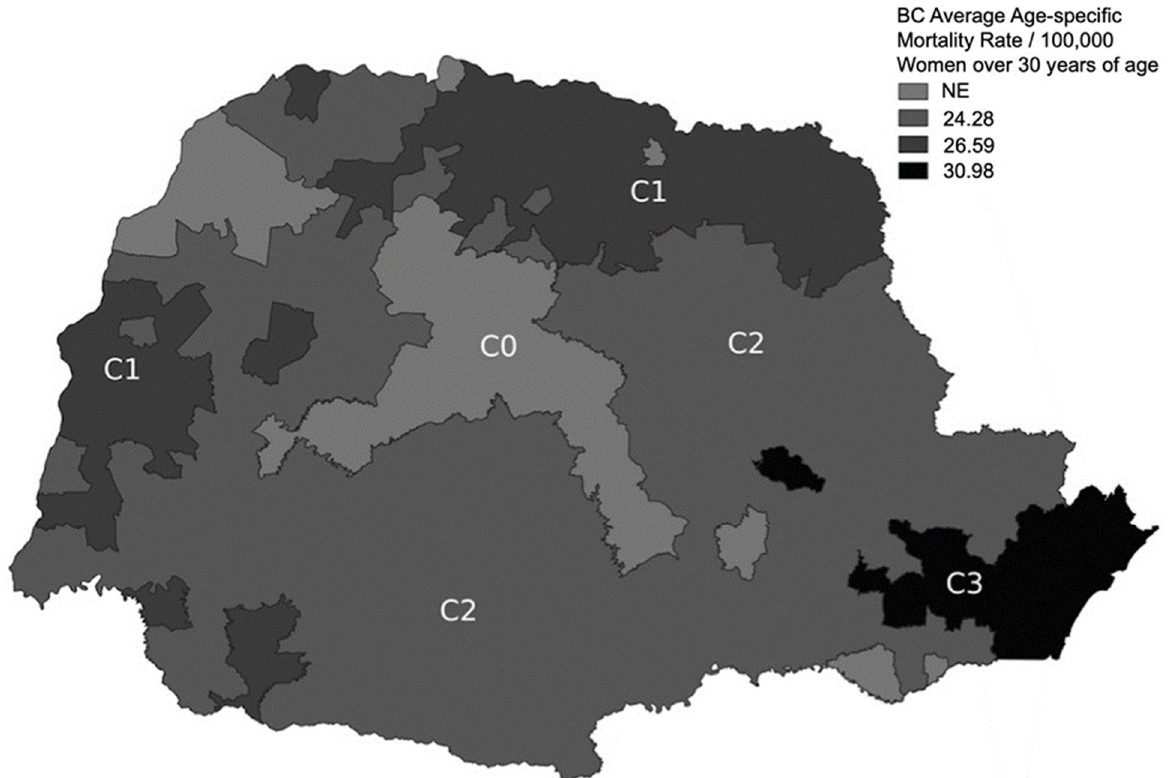
Figure 2. Breast cancer age-specific mortality rate (2005–2015) per 100,000 women over 30 years of age (Group 2). C0 was not evaluated. Table 5. TP53 p.R337H and XAF1 p.E134* variant allele frequencies in Group 3 ( n =